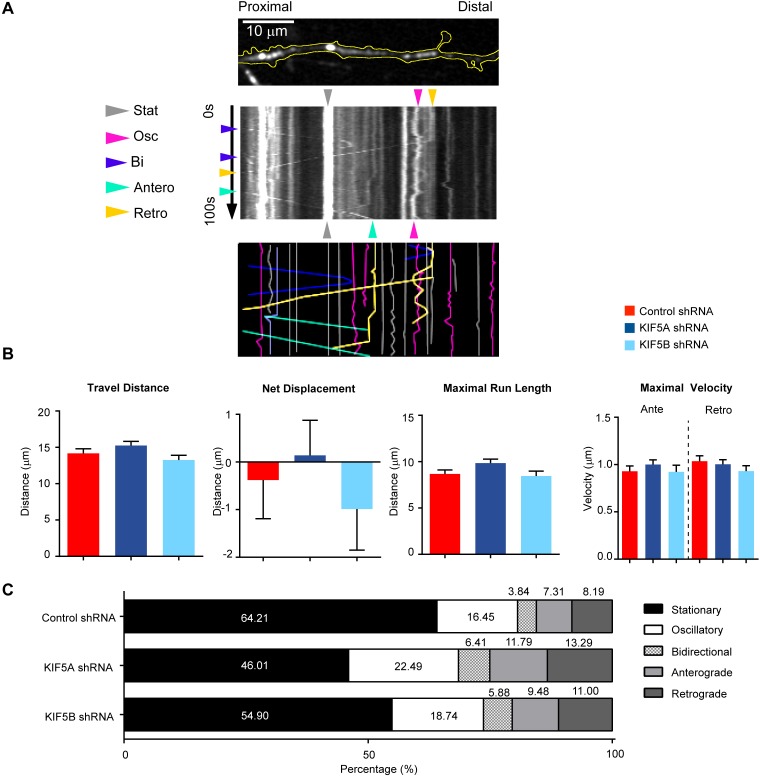
Quantification of GFP-FMRP granule motility and percentage of movements after knockdown of KIF5A or KIF5B.(A) Demonstration of GFP-FMRP granule quantification using kymograph tracing. Different types of movements were traced manually and displayed in different colors. (Stat: stationary; Osc: oscillatory; Bi: bidirectional; Antero: anterograde; Retro: retrograde.) Live imaging was conducted at one frame per second for 100 s. (B) The travel distance, net displacement, maximal run length and maximal velocity were analyzed for each unidirectional and bidirectional granule. 305, 462 and 242 granules from neurons transfected with control shRNA, KIF5A-shRNA, and KIF5B-shRNA were quantified, respectively. Data are presented in mean + SEM, Kruskal-Wallis, Dunn's multiple comparisons test. (C) The percentage of each type of granule movement were quantified. 1571, 1467 and 918 granules from neurons transfected with control shRNA, KIF5A-shRNA, and KIF5B-shRNA were quantified, respectively. The percentage of motile granules was increased after knockdown of KIF5A or KIF5B, while the motility of unidirectional and bidirectional granules was not affected.
Figure 3—figure supplement 1—source data 1.Plotted values for Figure 3—figure supplement 1.